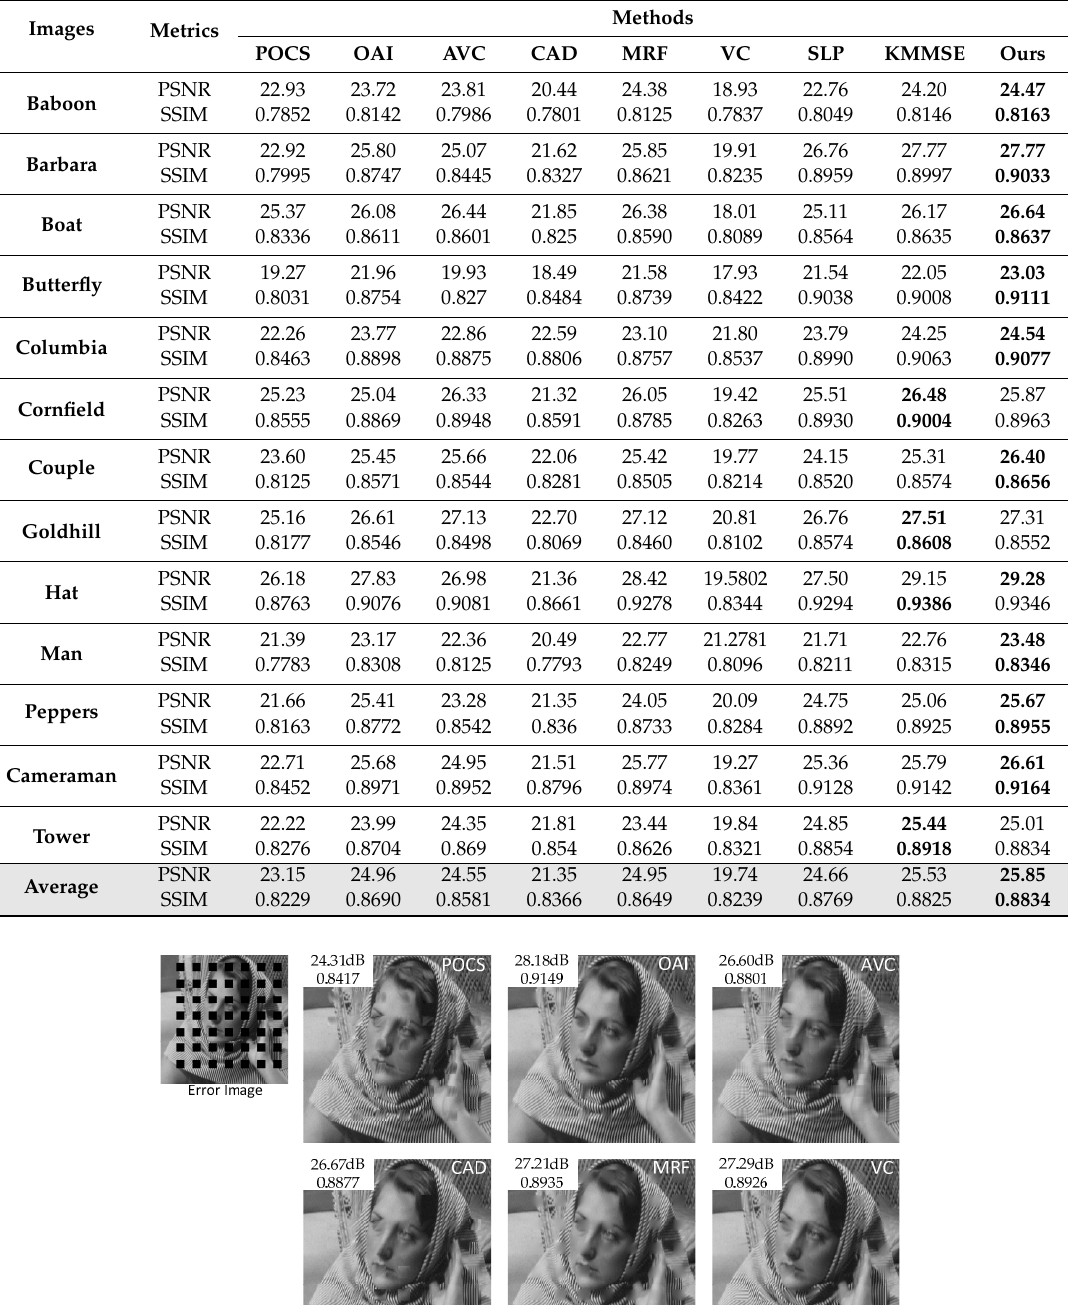
Table 4. PSNR and SSIM comparison of EC algorithms with 16 × 16 random consecutive block losses.